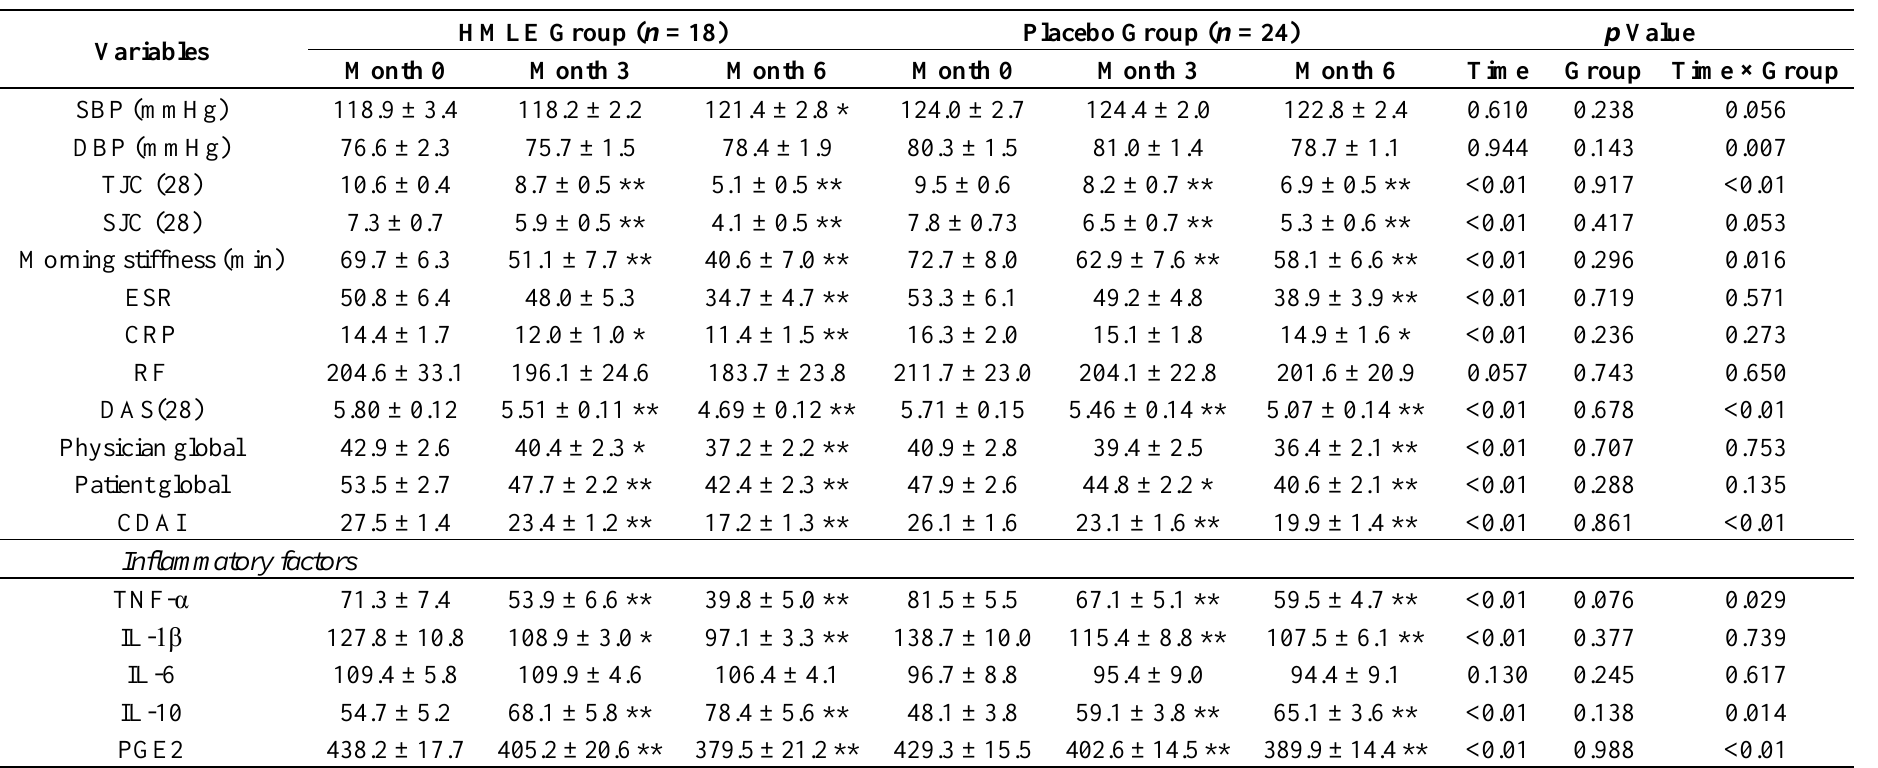
Table 6. Values of assessed clinical indicators for disease activity before and after